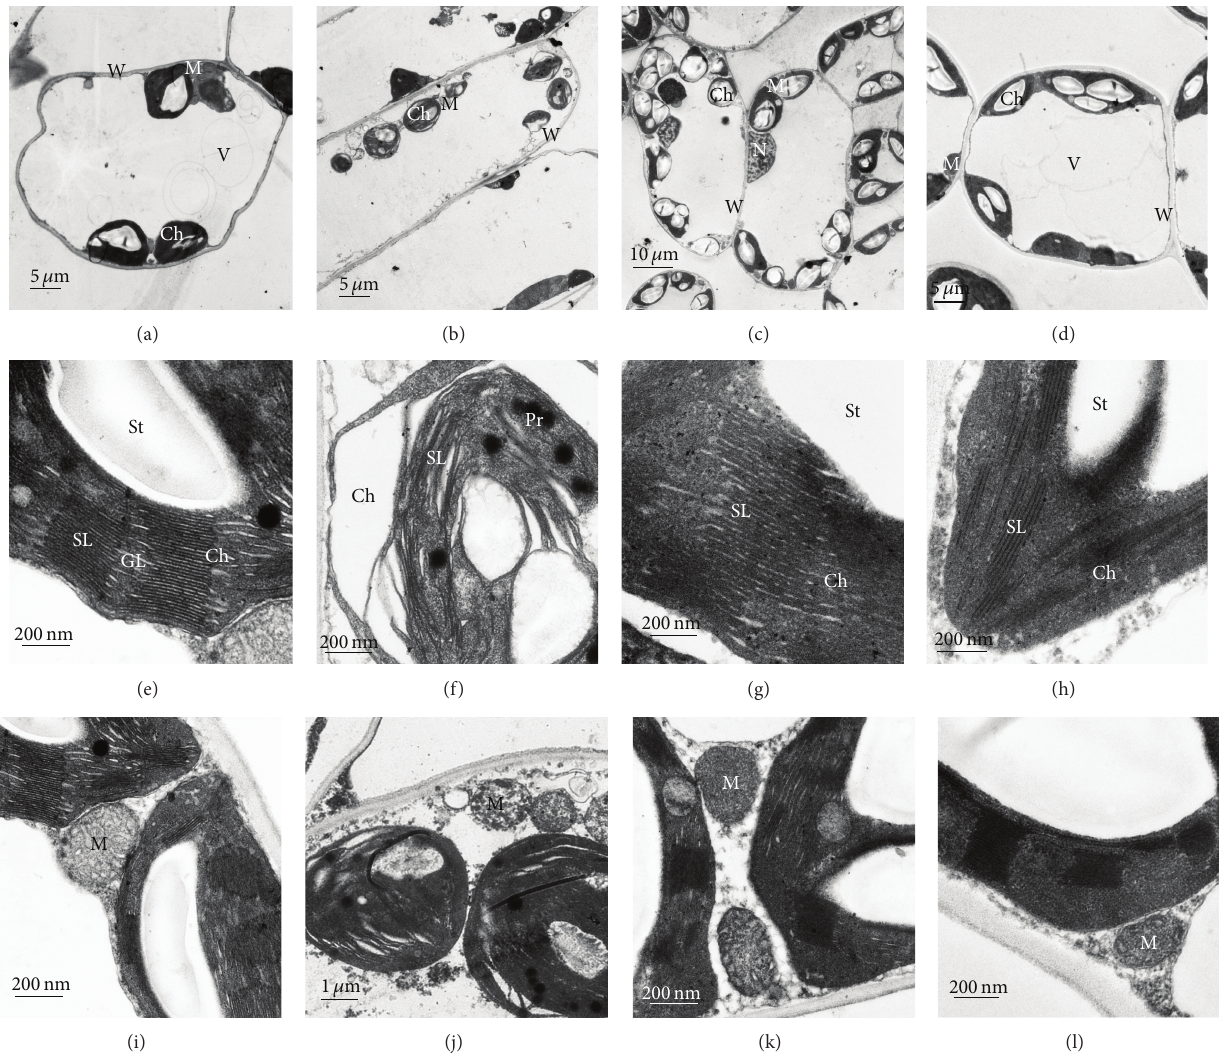
Figure 3: Effect of NaCl stress on leaf ultrastructure of A. scoparia and A. vulgaris “Variegate”. Mesophyll cells of untreated control (a) and NaCl-treated (b) plants of A. scoparia and of A. vulgaris “Variegate” ((c) and (d), resp.). Chloroplasts ((e)–(h)) and mitochondria ((i)–(l)) of the same plants in the same order. Abbreviations: Ch: chloroplast; M: mitochondria; W: cell wall; N: cell nucleus; V: vacuole; St: starch grain; SL: stroma lamelle; GL: grana lamelle; Pr: